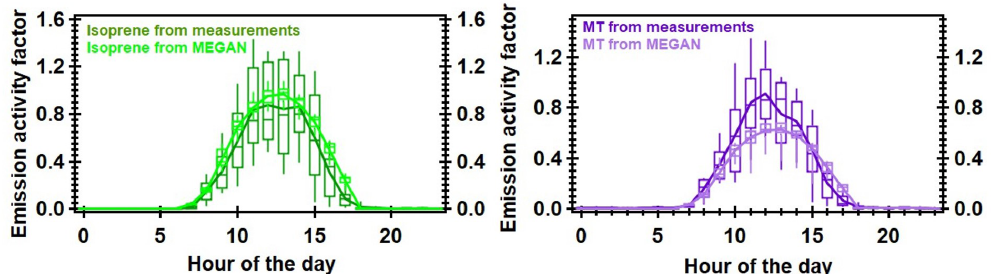
Figure 4. Comparison of diel profiles of the emission activity factors calculated based on the measured and MEGAN2.1-predicted isoprene and total monoterpene fluxes.